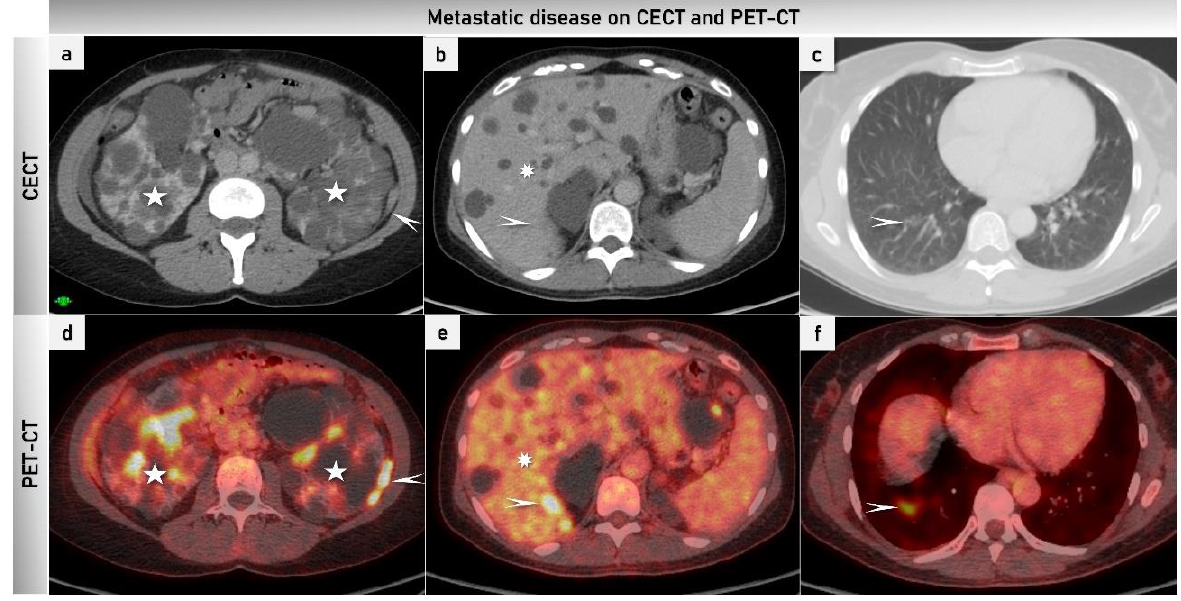
Figure 10. High-grade serous tubal cancer FIGO stage IVB. Axial CECT and PET-CT scans of the same patient as presented in Figure 9 are demonstrating the left paracolic peritoneal